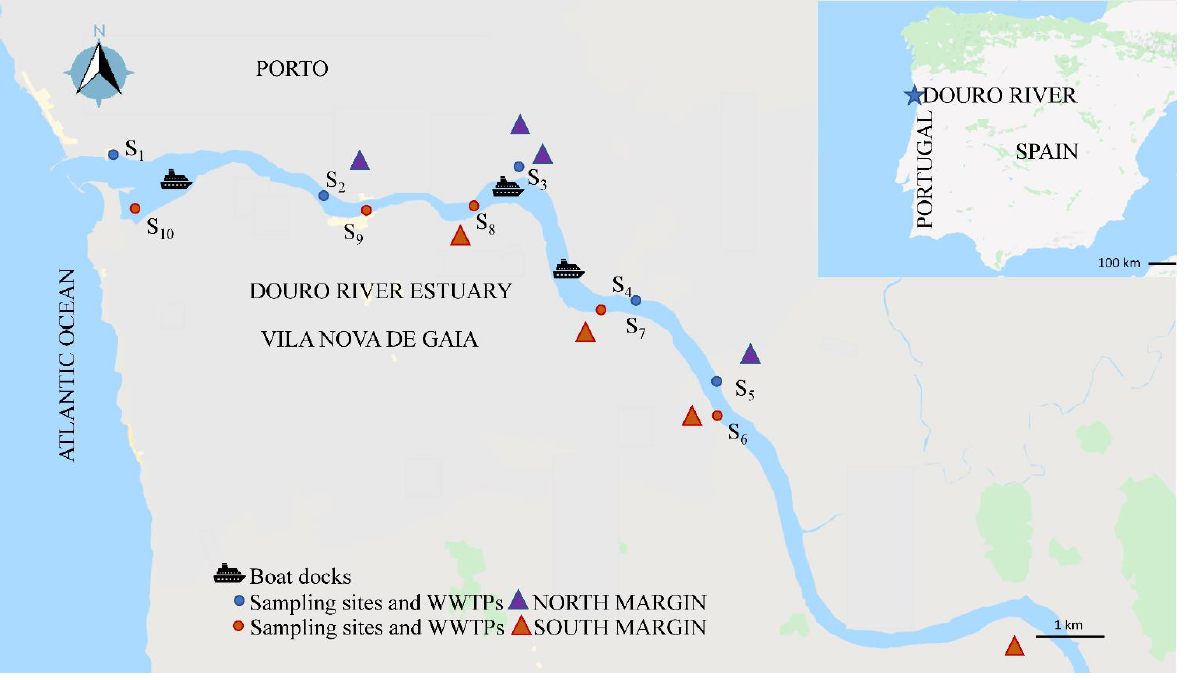
Figure 1. Location of the sampling sites within the Douro River estuary (S1 to S10), Portugal. For easier visualization, sampling areas at the north margin are marked in blue, and those at the south are in red. Anthropogenic sources that may contribute to higher amounts of EDCs, such as the WWTPs effluents and boat docks, are referred in this figure (adapted from KML Map).